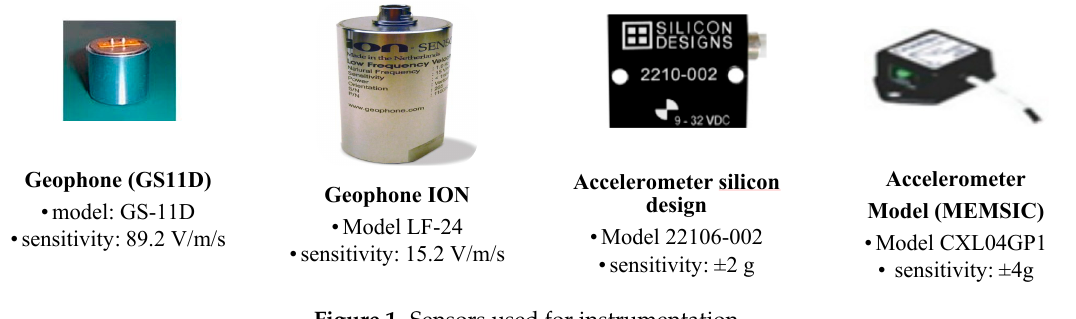
Figure 1. Sensors used for instrumentation.